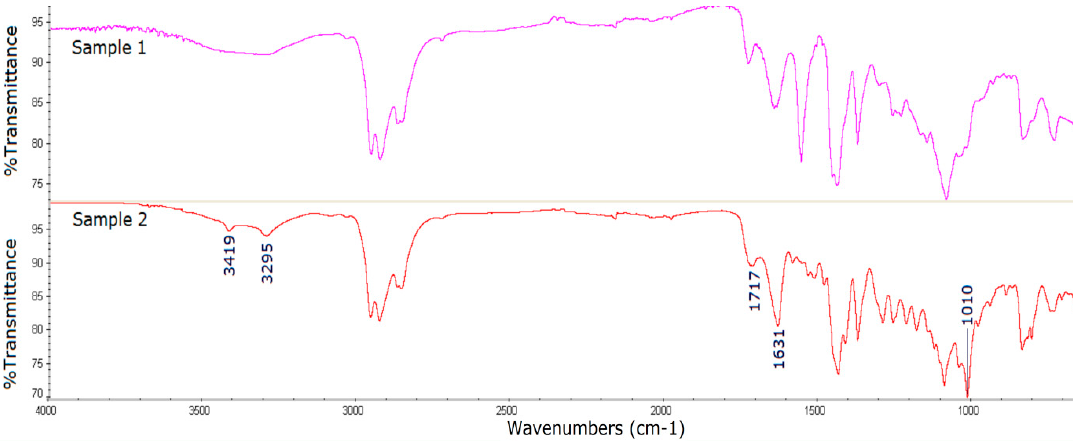
Figure 4. FTIR spectra of the iodine-activated latex catheter ( Sample 1 ) and sparfloxacin-treated catheter ( Sample 2 ).